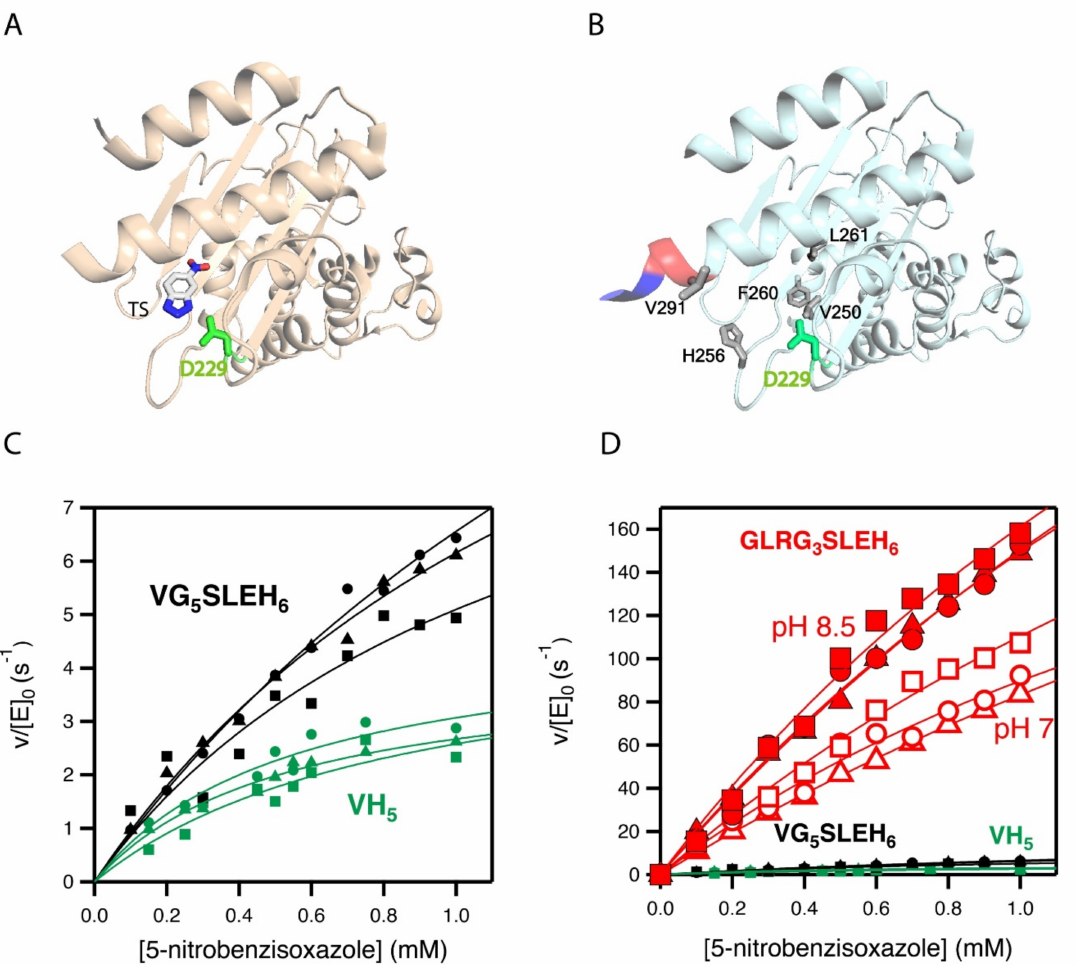
Figure 2. 3D structures and catalytic properties of the Kemp eliminase variants used as starting points for the enzyme engineering reported in this work. ( A ) Structure (PDB ID 5FQK) of the W229D/F290W variant of an ancestral β -lactamase with Kemp eliminase activity [33]. The W229D mutation generates the new function and the catalytic base (D229) introduced by the function-generation mutation is shown. The structure includes a transition state analogue (see Figure 1), which indicates the location of the new active site. ( B ) The Kemp elimination activity of the protein shown in A could be enhanced by several amino acid replacements at the de novo active site region, resulting from computationally focused ultra-low-throughput screening [34]. The activity-enhancing residues are highlighted in grey in the structure shown here (PDB ID 6TXD). The His-tag attached to the carboxyl terminus for purification purposes is also highlighted (red and blue colors). Note that one of the activity-enhancing mutations replaces the first histidine with a valine. Therefore, the protein shown has a VH 5 tail attached to the carboxyl terminus. The background variant used in this work has VG 5 SLEH 6 attached to the carboxyl terminus, introducing a polypeptide segment between the caxboxyl terminus and the His-tag, but keeping the valine. ( C ) Michaelis–Menten profiles for the proteins with VH 5 and VG 5 SLEH 6 attached to the carboxyl terminus. ( D ) The differences in catalysis observed in C are very small compared with the activity enhancement achieved in the screening efforts reported this work (variant with GLRG 3 SLEH 6 attached to the carboxyl terminus). Note that three Michaelis–Menten profiles were independently determined for each of the variants shown in ( C , D